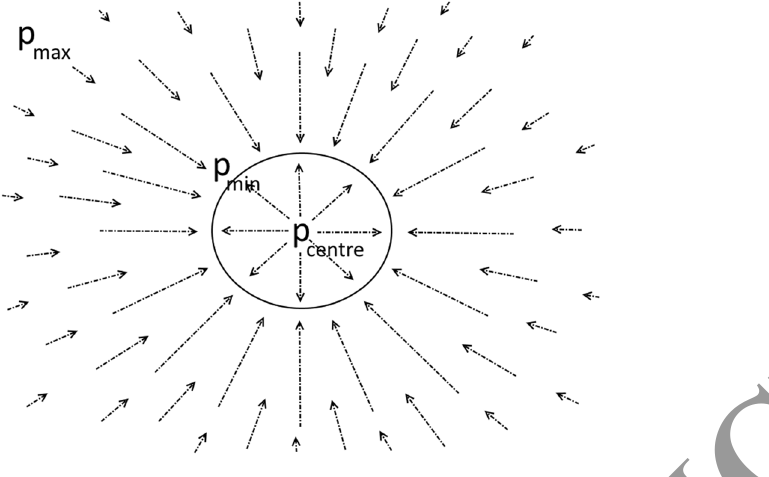
Figure 3. Binding and repulsive pressure of the proton as the result of vacuum fluctuations VF .